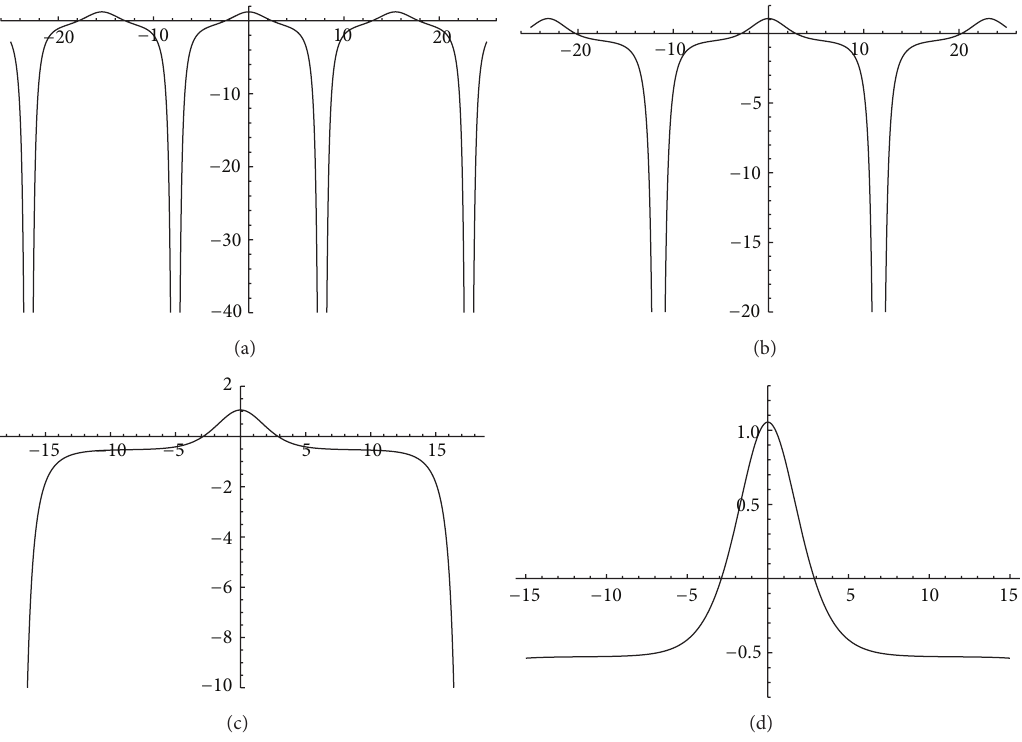
Figure 4: The varying process for graphs of 𝑢 12 (𝜉) when 𝑔 → 𝑔 2 + 0 , where 𝑎 = 1 , 𝑐 = 𝑏 = 𝑘 = 1/2 , and (a) 𝑔 = 𝑔 2 + 1/5 ; (b) 𝑔 = 𝑔 2 + 10 −2 ; (c) 𝑔 = 𝑔 2 + 10 −4 ; (d) 𝑔 = 𝑔 2 + 10 −6